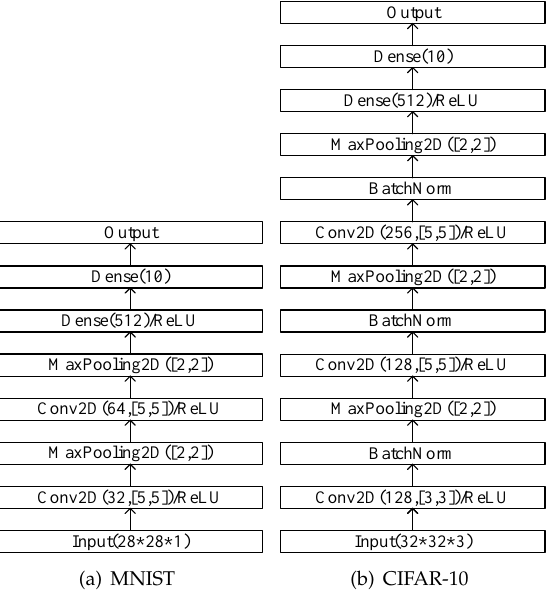
Figure 3. The network architectures of MNIST and CIFAR-10